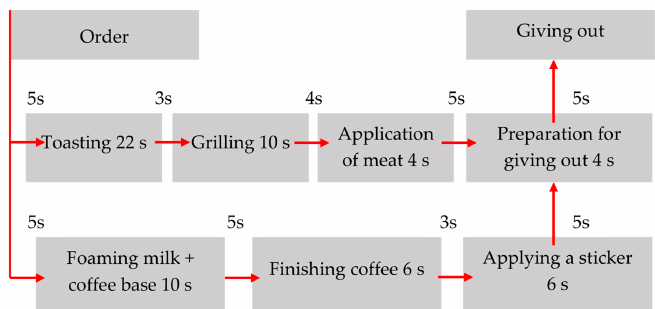
Figure 4. Value stream mapping (VSM) production of order before modernization.